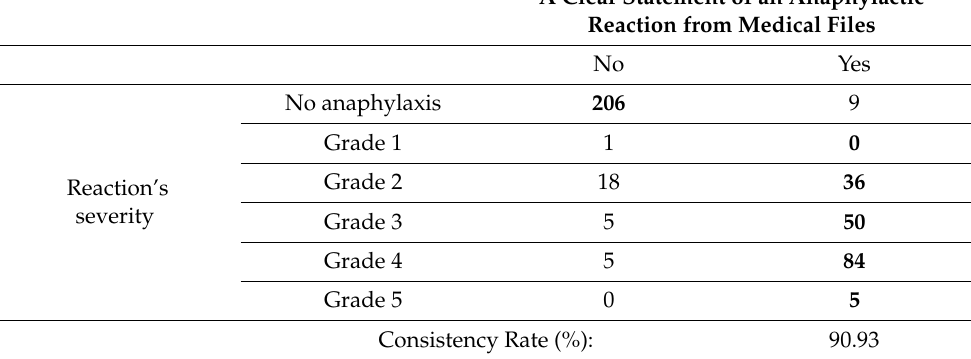
Table 3. Recording of “Anaphylaxis” diagnosis according to the reaction’s severity (based on Samp- son’s